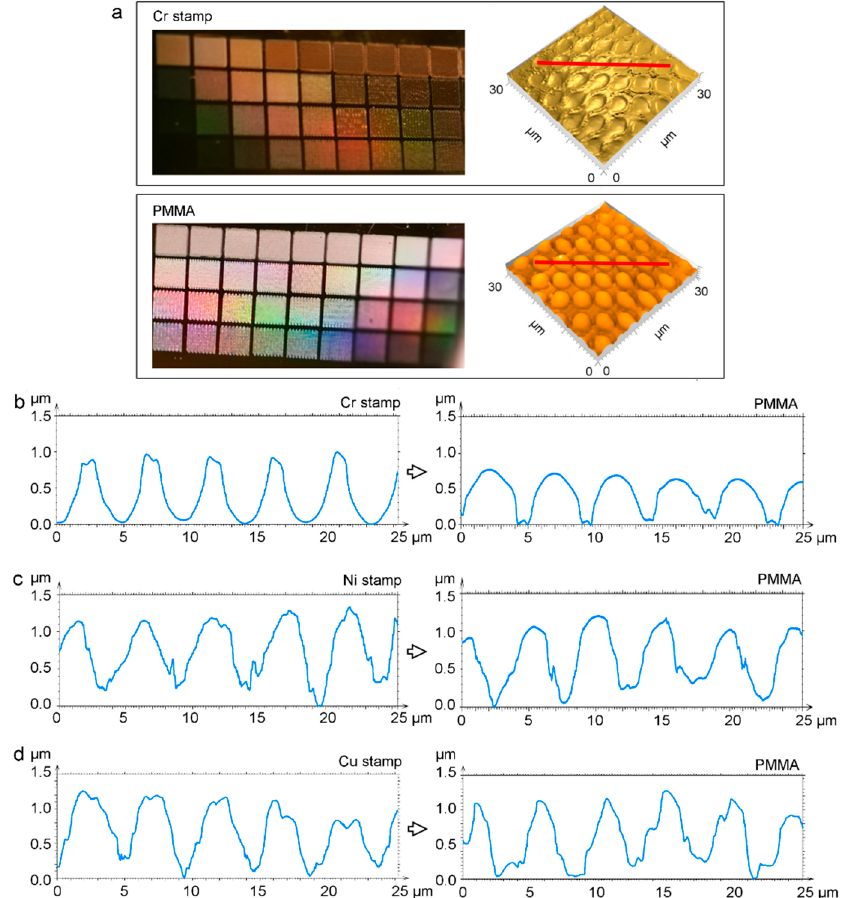
Figure 7. ( a ) Photographs and 3D topographies of a (top) Cr stamp and (bottom) embossed PMMA substrate. The red lines correspond to the positions where the profiles in ( b ) were extracted. (b, c, d) Topographical profiles of laser-treated metals ( b ) Cr, ( c ) Ni, ( d ) Cu, and the corresponding PMMA substrates imprinted from them by hot embossing. The embossing temperature was 100 ± 5 °C, the applied force was 200 kN, and the embossing time was 5 min.